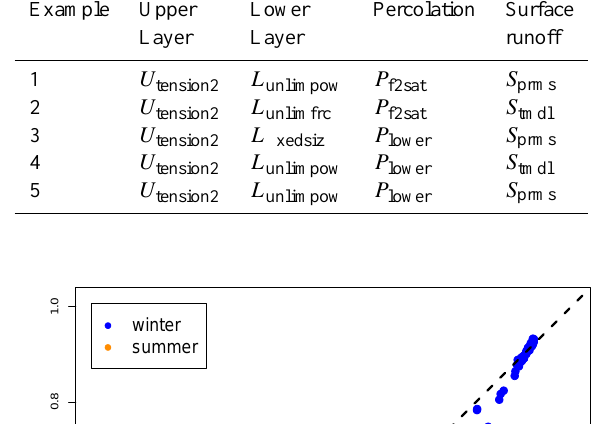
Fig. 8. Boxplots of model performance for summer and winter streamflow simulations for the three surface runoff decision